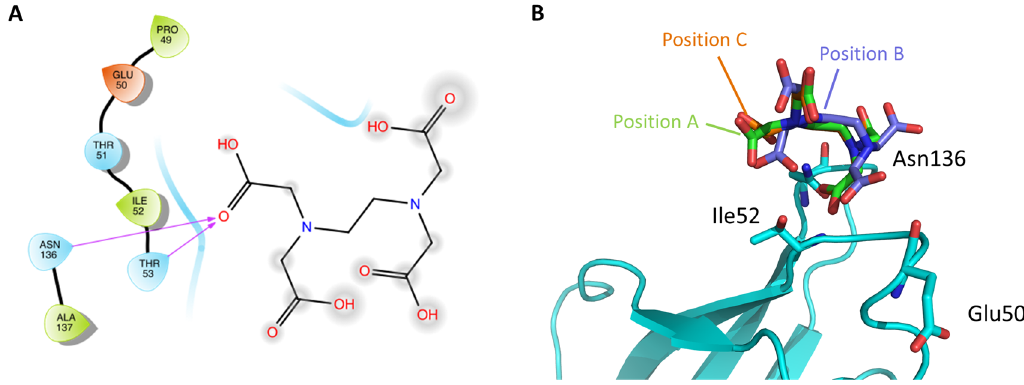
Figure 5. EDTA-binding site in the FimH lectin domain. ( A ) The 2D diagram of the binding site is depicted (prepared with maestro using a cutoff of 5 Å) ( B ) on the right the location of the binding site in the crystal structure (PDB code: 5FX3 [38]) is shown. Slightly different, alternative positions ( A – C ) of EDTA have been observed in the crystal structure and are colored differently (green, lilac, and orange).